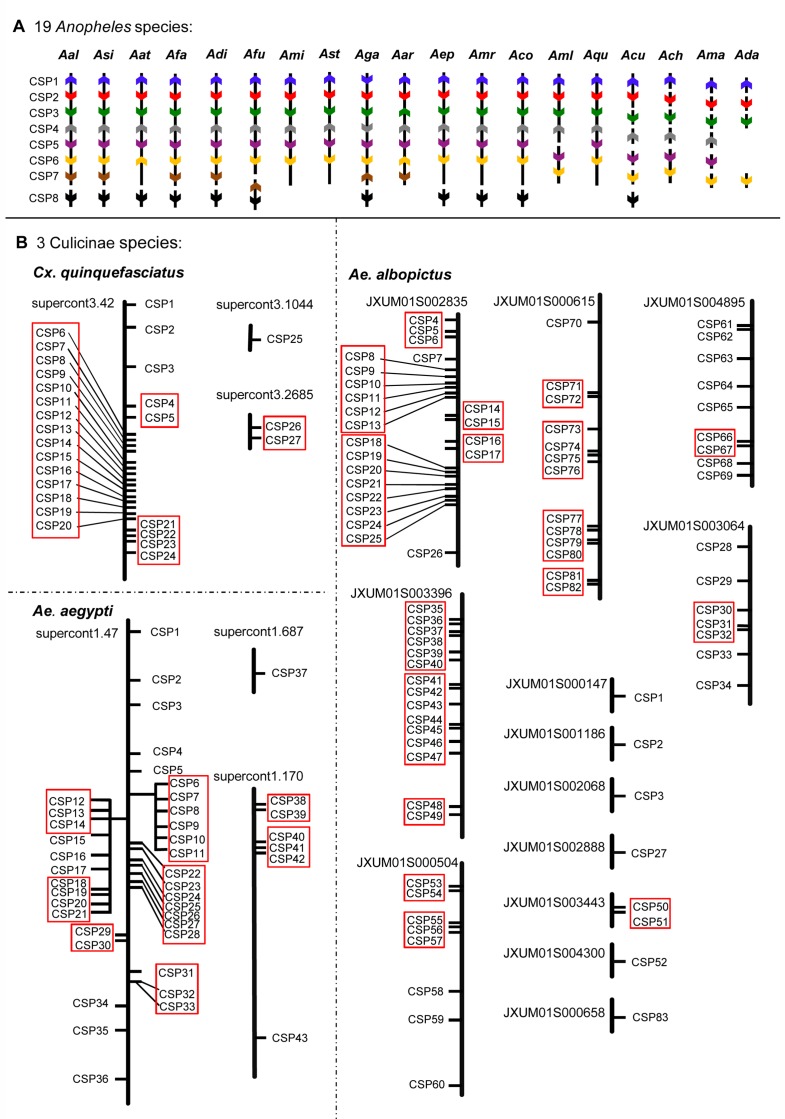
Genomic localization of CSP genes in 22 mosquito species.A) Relative positions of CSP genes in the 19 Anopheles species. The eight horizontal bars indicate eight different genes, marked in different colors with arrows showing the 5’-3’ direction of the sequences. B) Location of CSP genes in the three Culicinae species, with the 27–83 genes of each species marked in relative genomic distance. Gene clusters are represented by a red box.